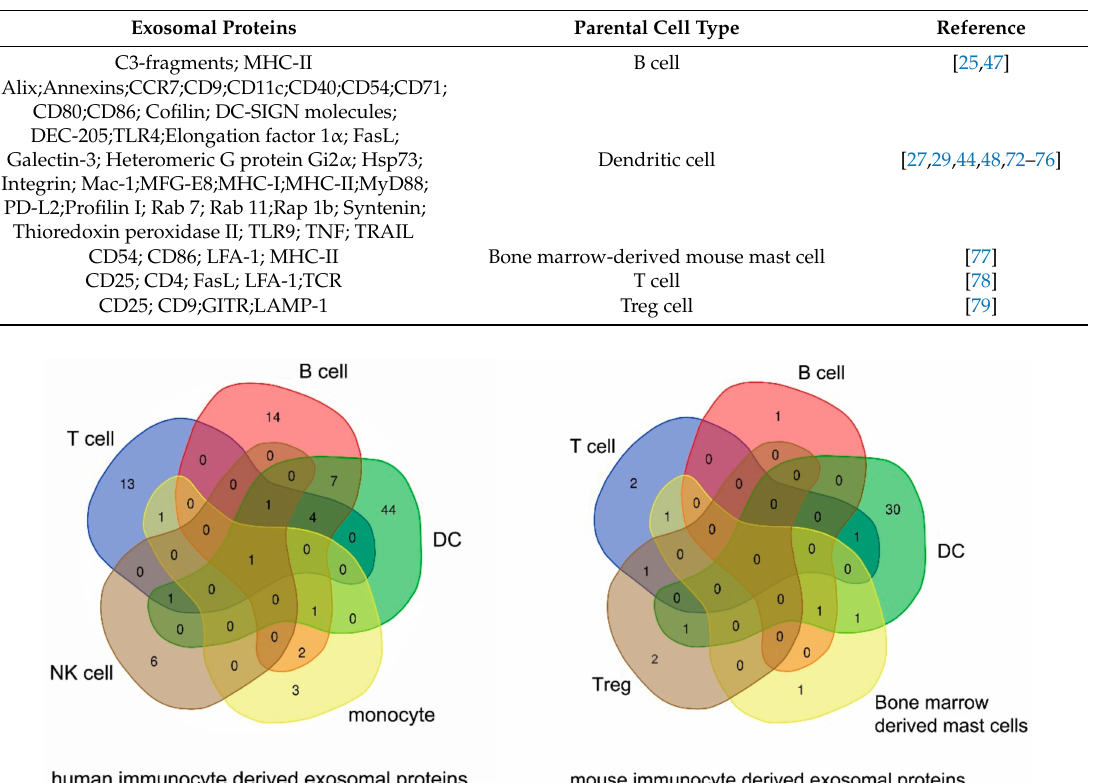
Table 2. Exosomal proteins of mouse immunocytes.